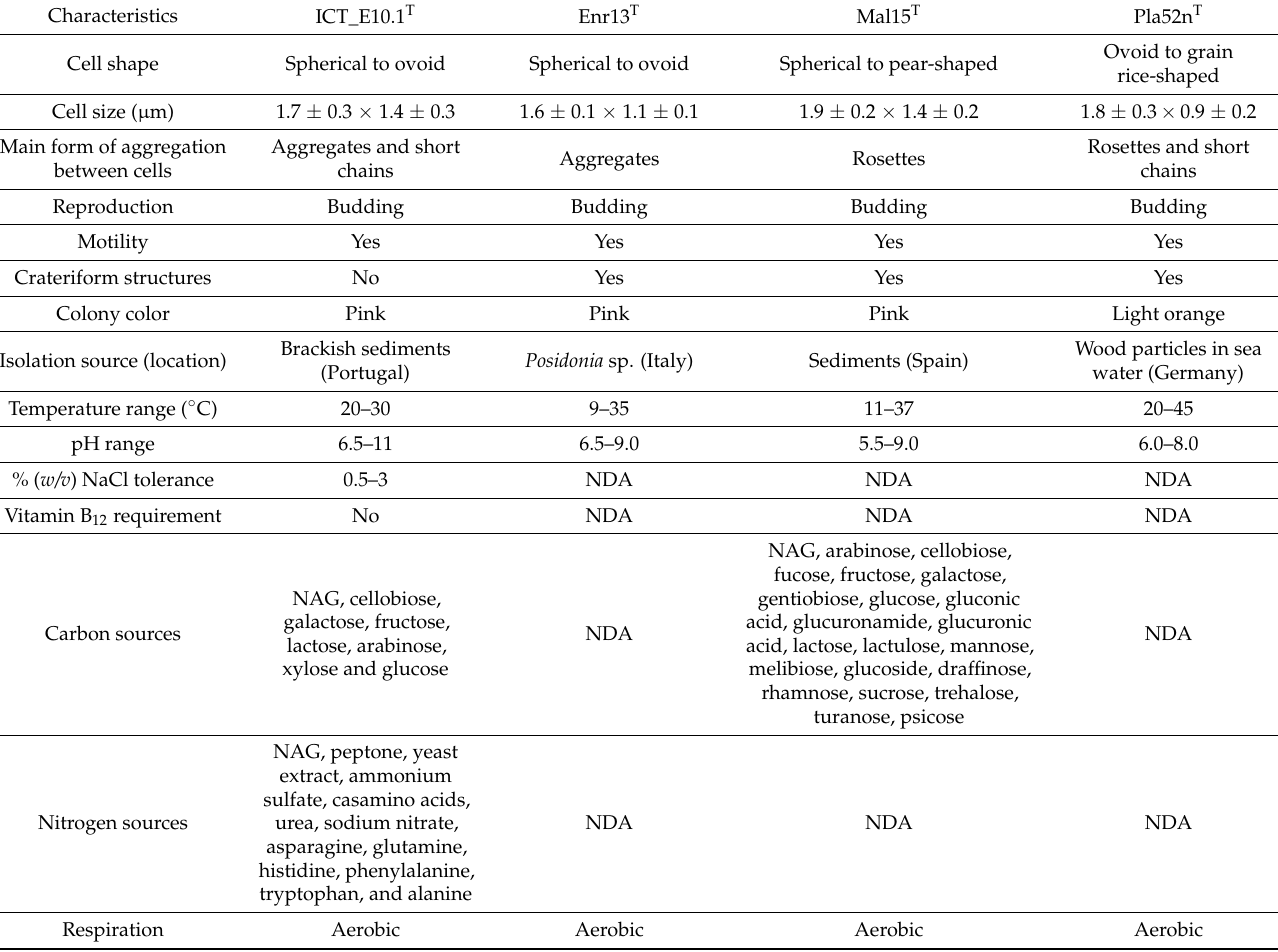
Table 3. Morphological, ecological, and physiological traits of strain ICT_E10.1 T compared to the current validly described members of the genus Stieleria . Data from Stieleria neptunia Enr13 T , S. maiorica Mal15 T , and S. varia Pla52n T was retrieved from species descriptions studies